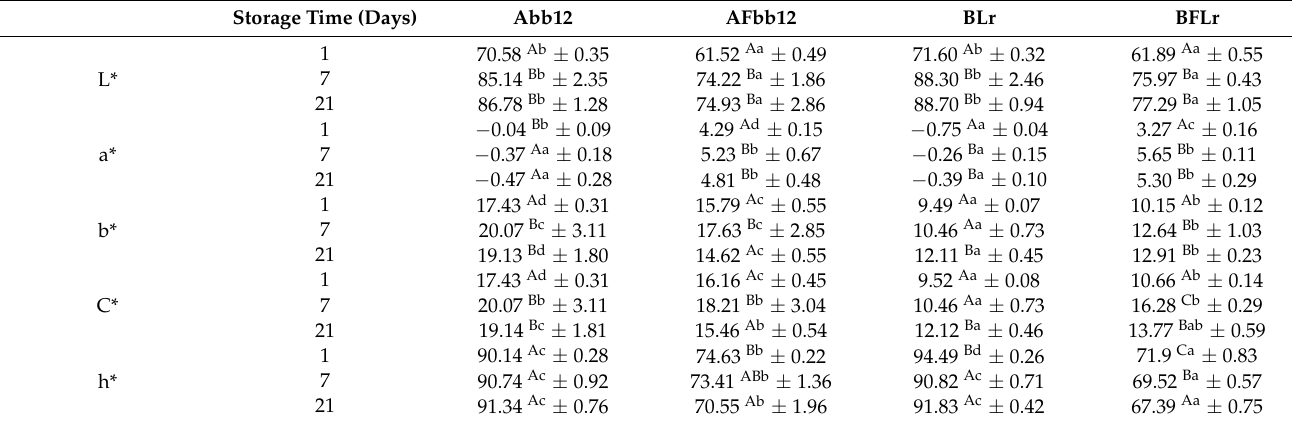
Table 5. Color parameters of ice cream sample in the ice cream mixture during